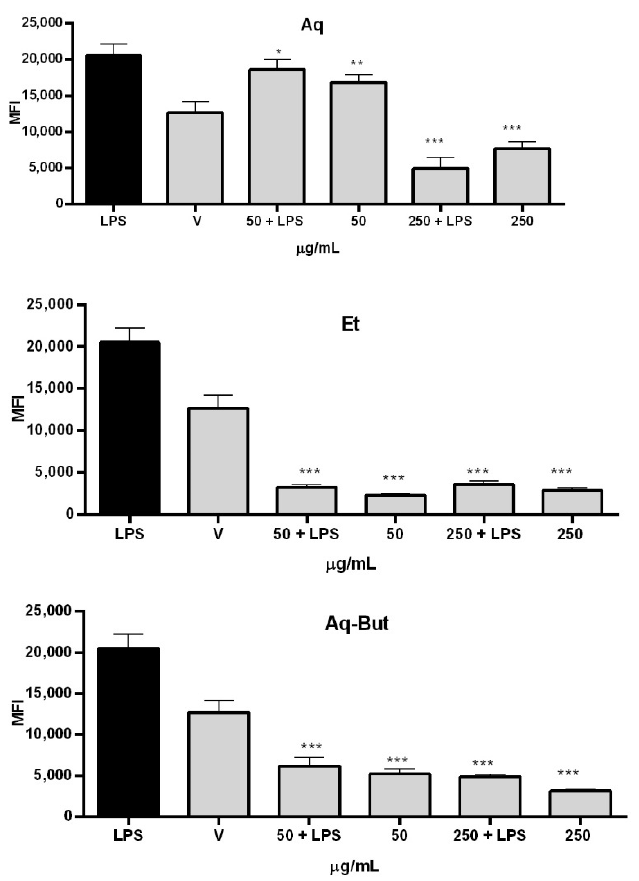
Figure 7. Reduction in ROS formation by THP-1 macrophages after treatment with M. albicans extracts, with or without LPS. Aqueous (Aq) and ethanol (Et) extracts, as well as the aqueous n -butanol fraction (Aq-But), were tested at 50 and 250 µ g/mL, with or without LPS (500 ng/mL). Statistical analyses were performed by one-way analysis of variance (ANOVA), followed by Bonferroni’s test, for selected pairs. Results represent the mean ± SD of two independent experiments ( n = 2, in triplicate); * p < 0.05, ** p < 0.01, *** p < 0.001 versus LPS.